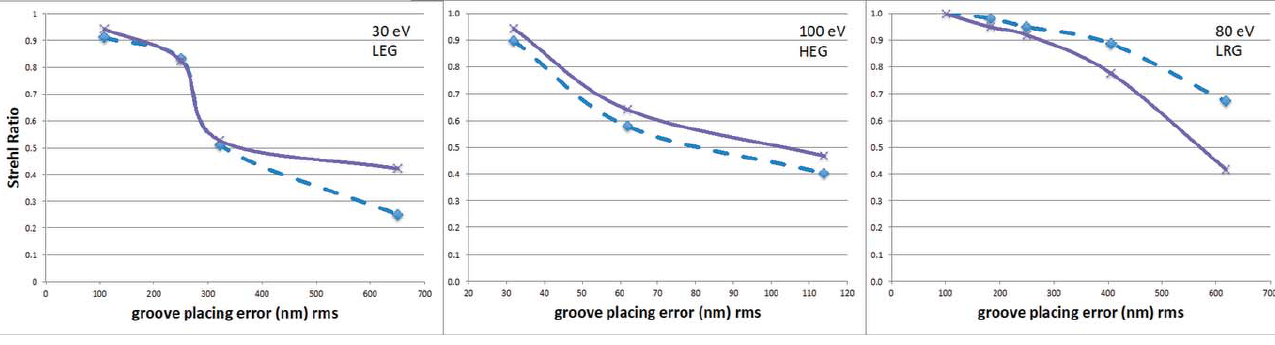
Figure 11 Strehl ratio calculated by using equation (14) (purple lines) over 2 FWHM and simulated using WISER (blue dashed lines). The relative intensities are shown in Figs. 8, 9 and